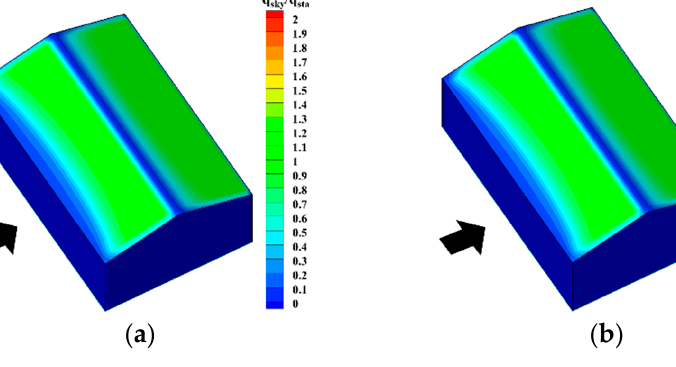
Figure 21. Spatial distribution of the normalized deposition flux of falling snow q sky / q sta with different snowfall intensities: ( a ) volume fraction: 7.8 × 10 − 6 ; ( b ) volume fraction: 1.56 × 10 − 5 ; ( c ) volume fraction: 2.34 × 10 − 5 .